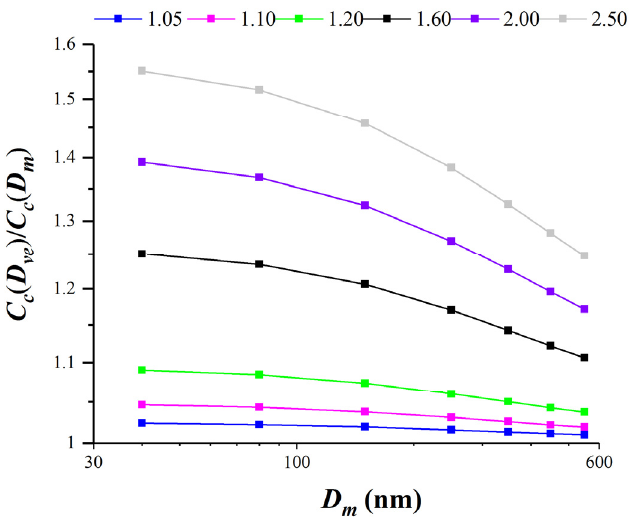
Figure 3. The relationship between the C c ( D ve )/ C c ( D m ) and D m for the Z particles with fixed ρ of 1.80 g/cm 3 and different χ values of 1.05, 1.10,1.20, 1.60, 2.00, and 2.50, which are represented by different colors.